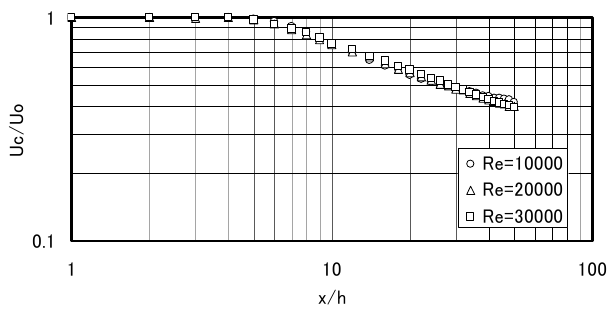
Fig. 11 Velocity decay of the jet center ( Re =3.0×10 4 ).